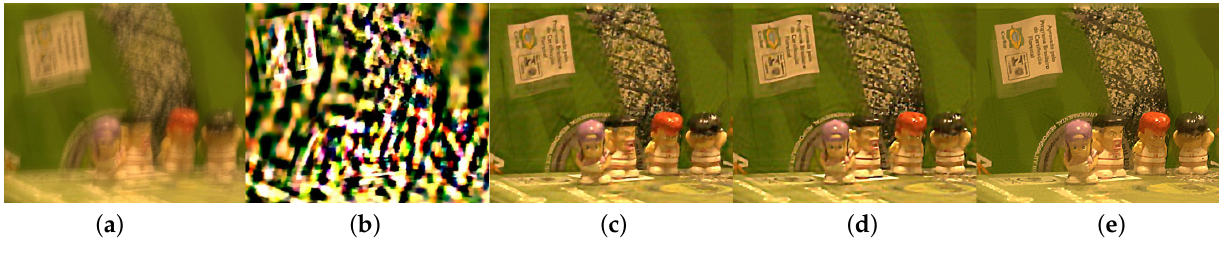
Figure 9. An example of real-world image results. The images ( a – e ) are blurry input, result of Krishnan et al. [14], result of Pan et al. [18], result of Yan et al. [19] and our result,